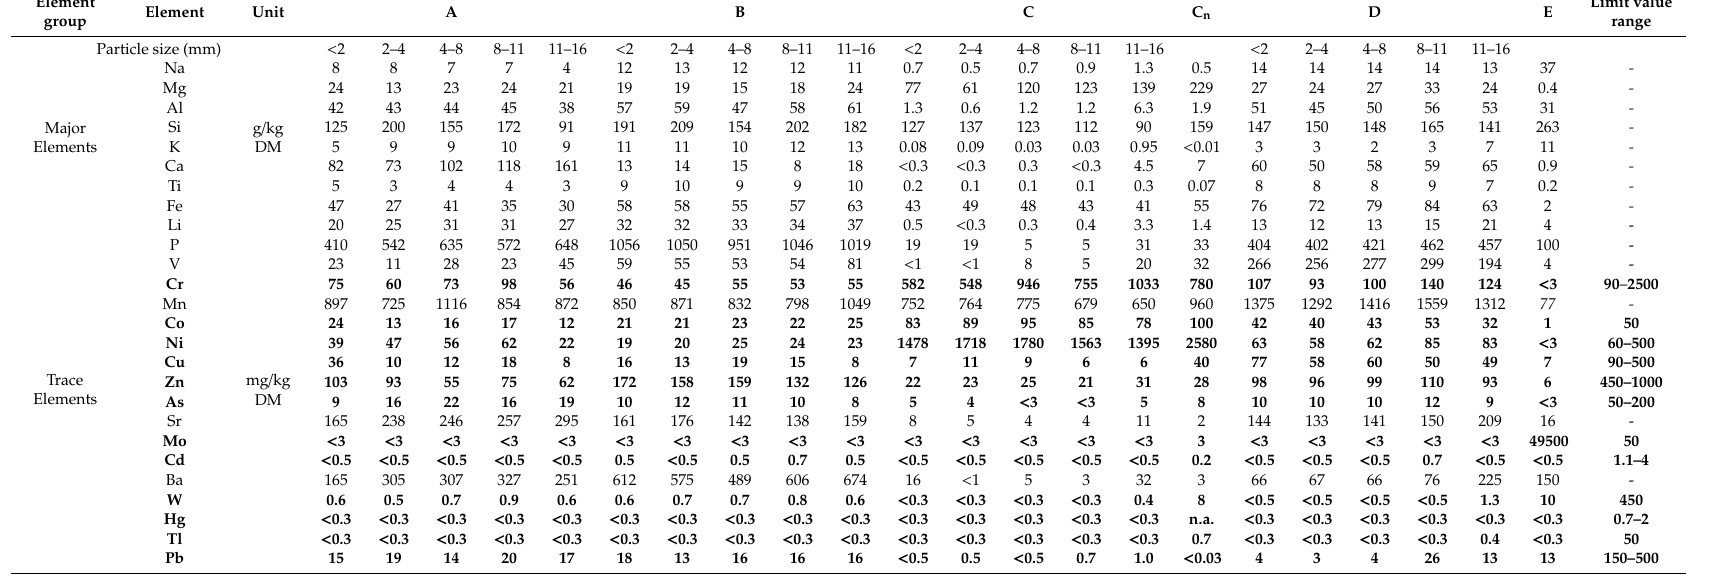
Table 1. Chemical bulk composition of the investigated samples A: quaternary gravel, B: diabase greywacke mixture, C: serpentinite; D: amphibolite breccia; terminology is according to the supplier and not according to scientific rock classification. Bold script: elements whose total contents are regulated in Austrian legislation for industrial and recycled aggregates. All results refer to dry matter (DM). n.a.: not analyzed. The range of limit values for the recycled and industrial aggregates of di ff erent quality classes [4] are given for orientation only as they are (i) not valid for natural aggregates and (ii) refer to aqua regia digestion. The estimated extended relative measurement uncertainty according to the EURACHEM / CITAC guideline is in the range of 30 to 35% for most